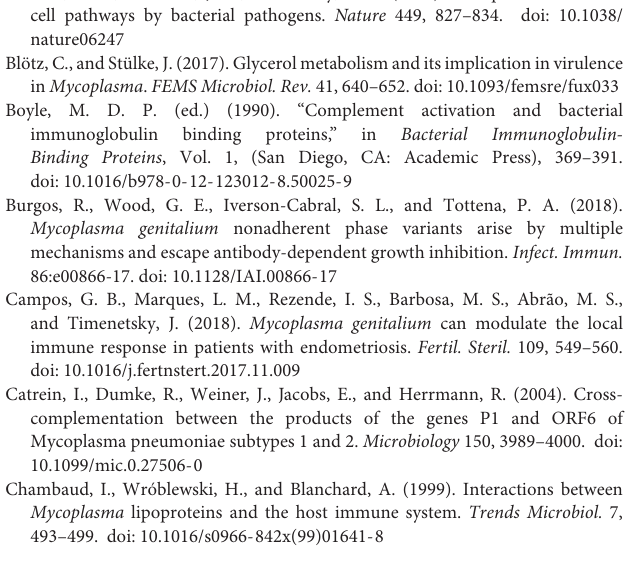
FIGURE S1 | Ability of IbpM to bind different Ig’s and the effect of the C-terminal region on binding. Using ELISA, purified full-length IbpM was coated in different concentrations onto 96-well plates and incubated with IgG (A) , IgA (B) or IgM (C) . Binding of Igs was quantified by the detection with rabbit α -human Ig -AP antibody responsible for ABTS color formation and detection at 420 nm. The statistical significance of the influence of the C-terminal region on the binding between IbpM and Igs is indicated by the following scheme: **** is P ≤ 0.0001, *** is P ≤ 0.001, ** is P ≤ 0.01, ns is P > 0.05. TABLE S1 | MPN400 pulldown complete protein pulldown list. DATA SHEET S1 | Original Blots Figures 2 , 3 , 5